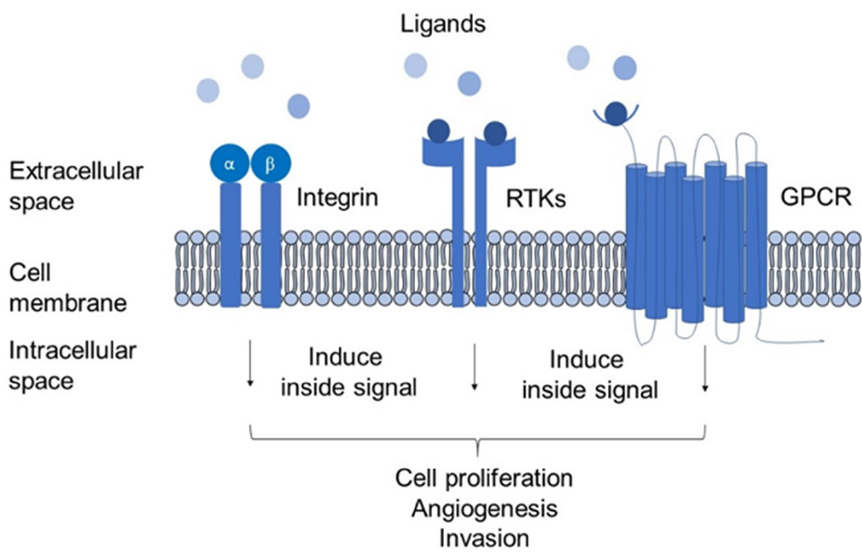
Figure 1. Membrane proteins induce cell responses leading to cancer.